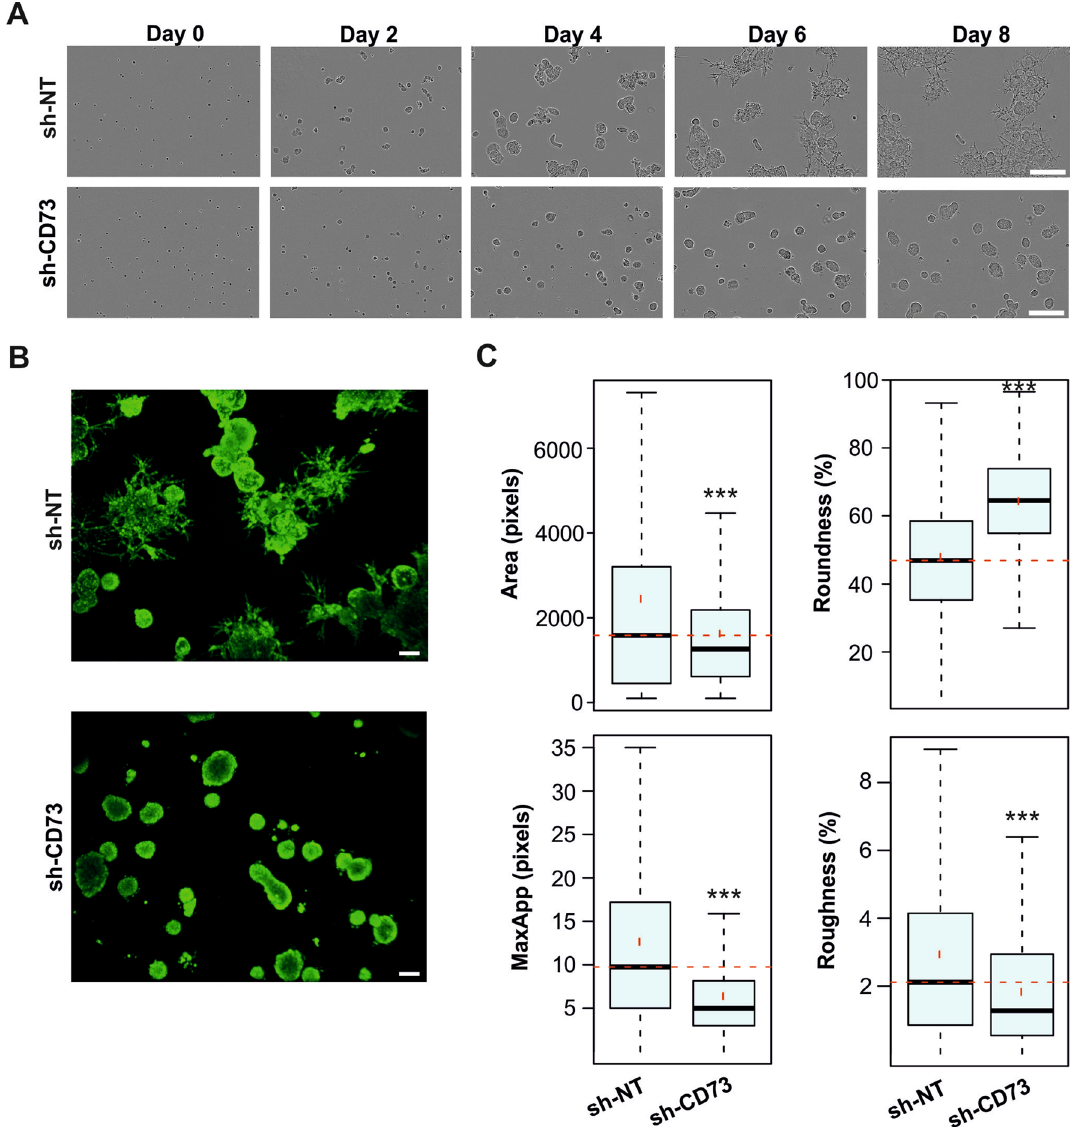
Figure 3. CD73 suppression prevents TNBC organoid invasion. ( A ) Sh-NT and sh-CD73 4T1 cells were grown in 3D culture. Representative images from days 0 to 8 are shown. Scale bar: 300 μm. ( B ) Confocal spinning disk microscopy images of sh-NT and sh-CD73 3D culture after 6 days. Calcein AM was used to detect living cells (green). Scale bar: 100 μm. ( C ) Box and whisker plots of selected parameters. Spheroid growth is indicated by the Area of the organoids. Roundness serves as a measure for the loss of the round organoid phenotype, and is associated with invasive properties. Roughness of the segmented structures and the maximal length of cellular protrusions emerging from the core structure (MaxApp) are quantitative measures for local invasion and cell motility. ***P < 0.001; sh-CD73 vs sh-NT spheroid formation, n = 1038 sh-NT organoids analyzed, n = 1080 sh-CD73 organoids analyzed; mean ± SD, by a Bonferroni-corrected post-test from T-tests. Data represents two independent CD73 facilitates EMT progression in TNBC cells. We next investigated whether the differences between sh-NT and sh-CD73 cells detected in the migration assays and in the 3D organoid model are associated with cell protrusion lengths. APCP treatment significantly shortened protrusions in parental 4T1 cells both in normoxia (p = 0.0090) and in 1% O 2 (p = 0.0062), as compared with vehicle treatment (Fig. 4A,D). In parental MDA-MB-231 cells, hypoxia increased protrusion lengths (p = 0.017), and this was significantly inhibited by APCP in 1% O